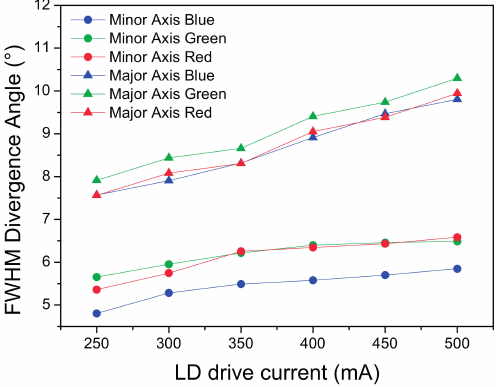
Figure 18. RGB FWHM divergence angle analysis for the reflective LARP setup nr. 1.